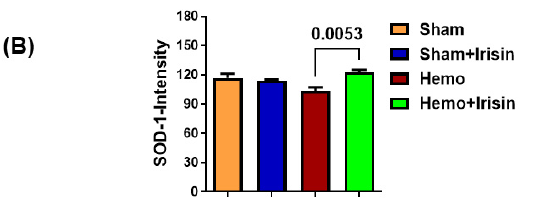
Figure 7. ( A ) Immunohistochemical staining of superoxide dismutase (SOD) in skeletal muscles; ( B ) A bar graph for statistical data of SOD intensity from A (data are shown as Mean ± SEM, n = 4/each group). Hemo: Hemorrhage, Scale bar: 50 µm.